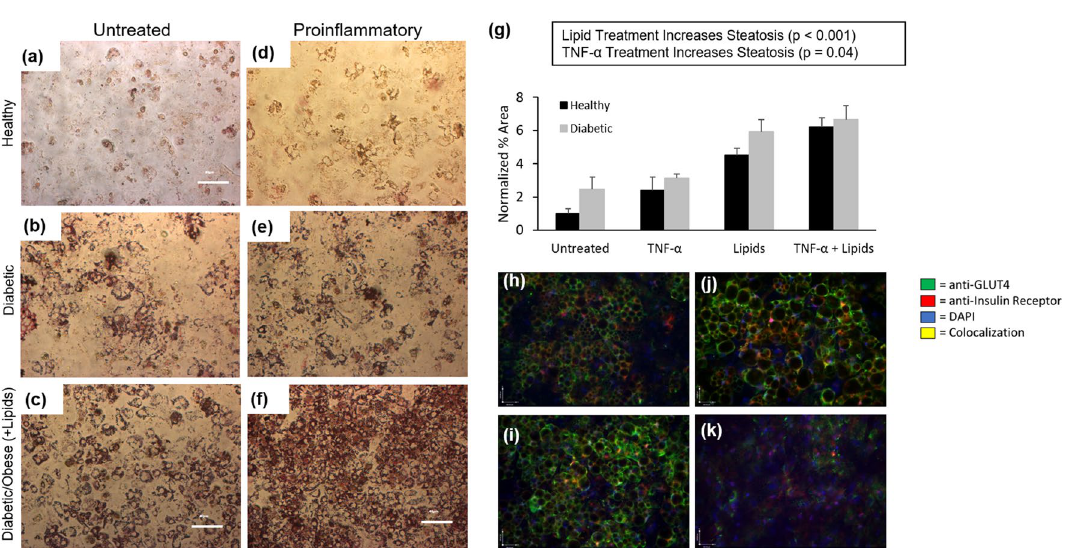
Figure 4. Expression of NAFLD phenotype in 2-chamber systems. Oil Red O staining showing lipid accumulation in hepatocytes after 14 days in recirculating 2-chamber systems containing ( a ) Healthy BMM ( b ) Diabetic BMM ( c ) Diabetic + obese BMM ( d ) Proinflammatory BMM ( e ) Diabetic + proinflammatory BMM ( f ) Diabetic, obese + proinflammatory BMM). ( g ) Quantification of hepatocyte lipid accumulation. ICC quantification of insulin resistance biomarkers after 14d in recirculating ( h ) Healthy BMM ( i ) Diabetic BMM ( j ) Diabetic + Obese BMM ( k ) Diabetic, obese, and proinflammatory BMM. Statistical analysis performed as multi-way ANOVA followed by Dunnett’s test (α = 0.05) using the coverslip-wide average of two independent coverslips per Proinflammatory medium increases hepatocyte lipid storage in a multi‑chamber plat‑ form.